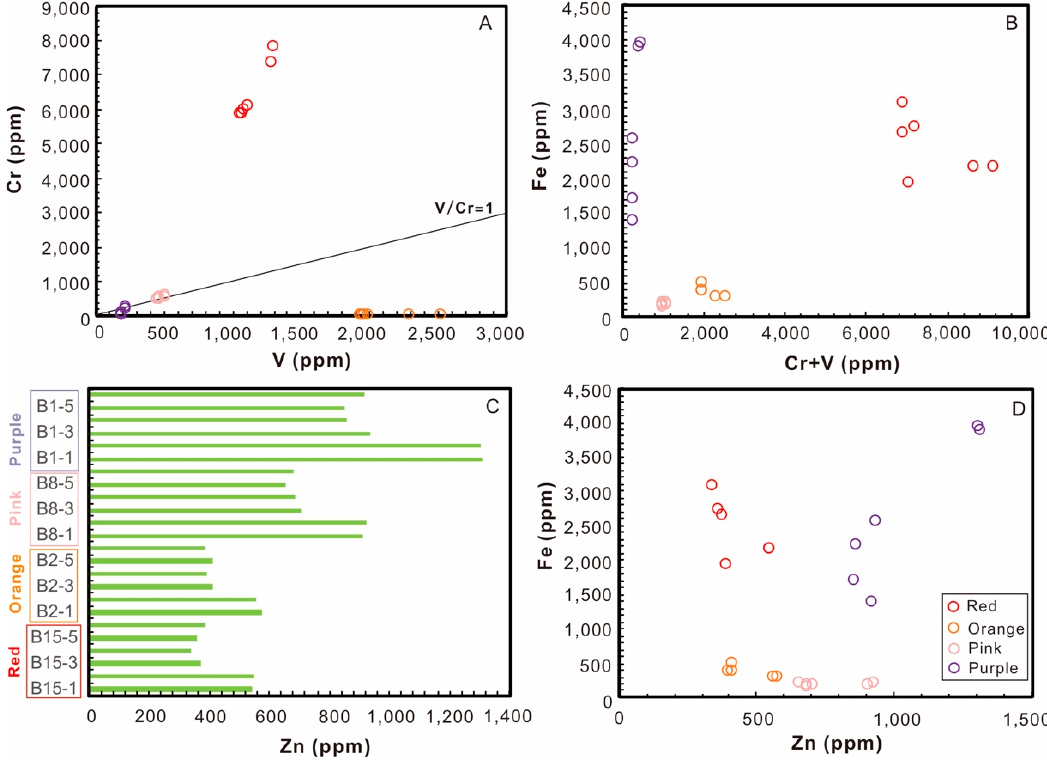
Figure 13. V–Cr ( A ), Cr+V–Fe ( B ), Zn–Fe, ( D ) diagram and histogram ( C ) of Zn trace element composition of Mogok spinel samples.